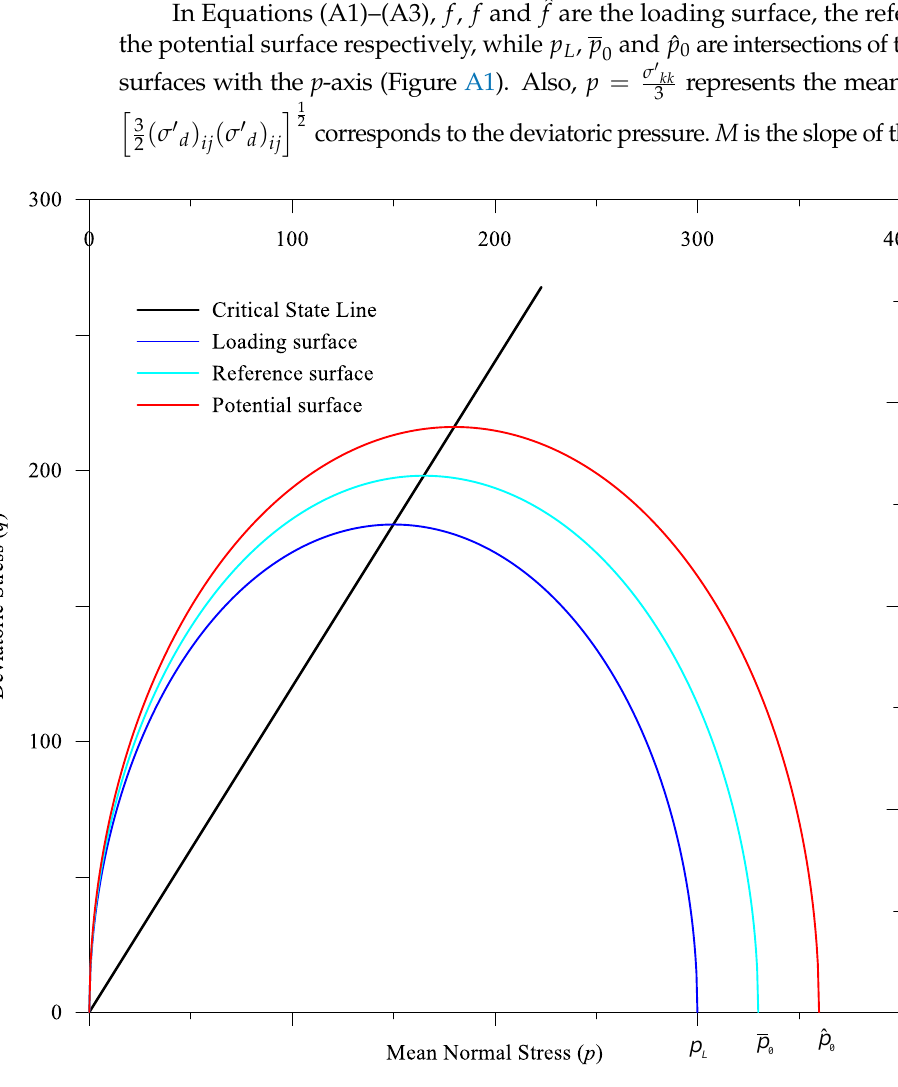
Figure A1. Three surfaces of the NAFR based EVP model.